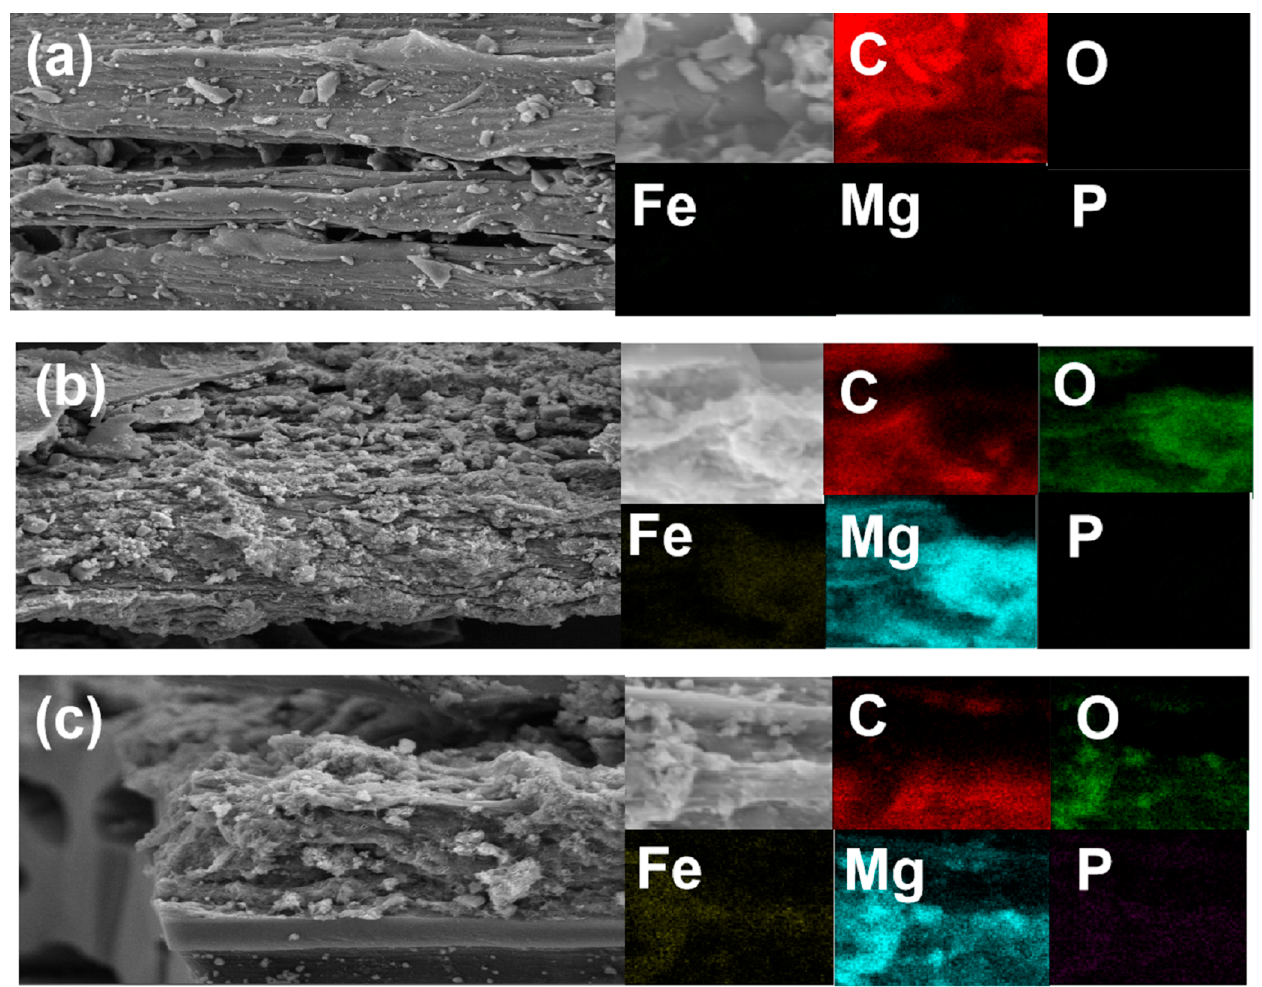
Figure 1. SEM and EDS element mapping of BC ( a ), LDHs-BC4 ( b ), and LDHs-BC4 after phosphate recovery ( c ).